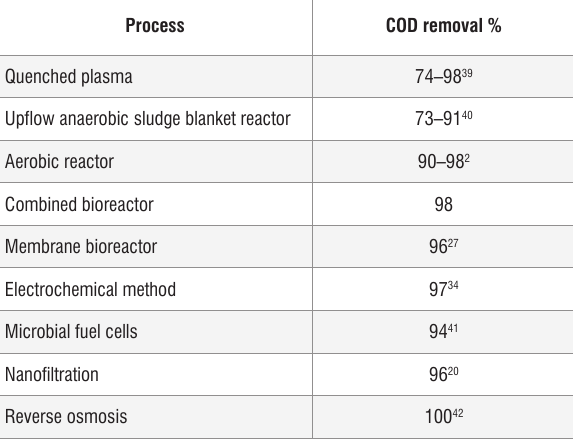
Methods used for the treatment of brewery effluent and the efficient removal of chemical oxygen